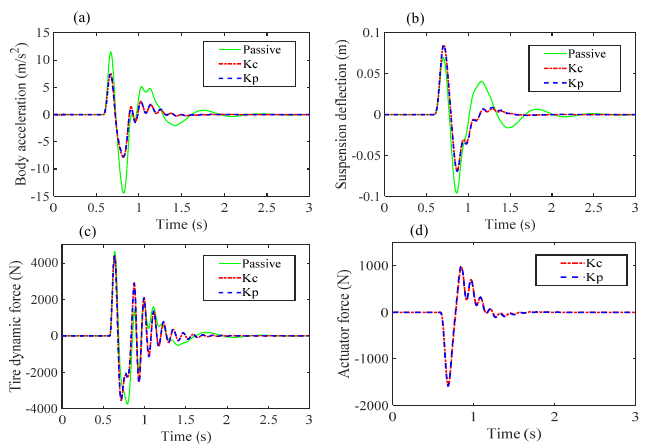
Figure 9. Vehicle dynamic responses under bump excitation: ( a ) body acceleration; ( b ) suspension deflection; ( c ) tire dynamic force; ( d ) actuator force.